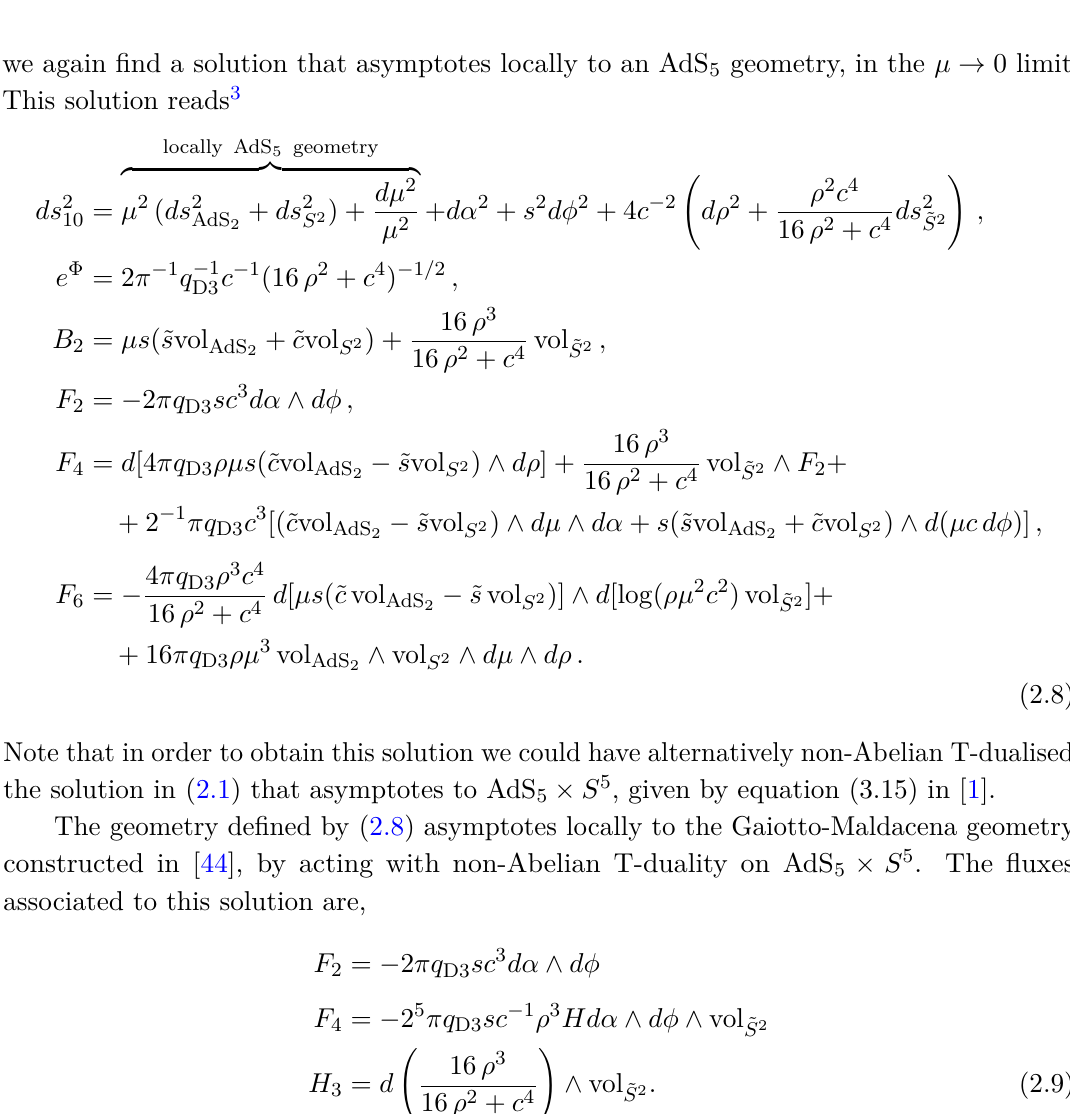
Table 2 . BPS/8 intersection describing D2-F1-D4’-NS5’ branes ending on D4-D6-NS5 branes, associated to the class of solutions (2.4). As before, x 1 , x 2 , x 3 parametrise the directions realising the SO(3)